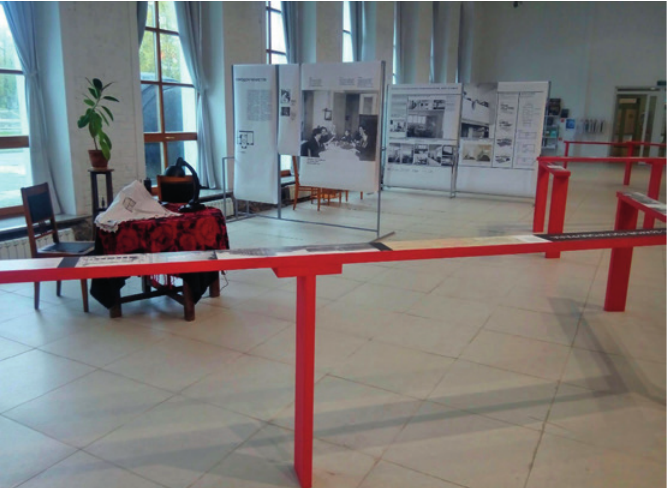
Figure 1. The exhibition “Villages of Sverdlovsk: from an architectural project to social experience”. Photo by Liudmila Starostova,